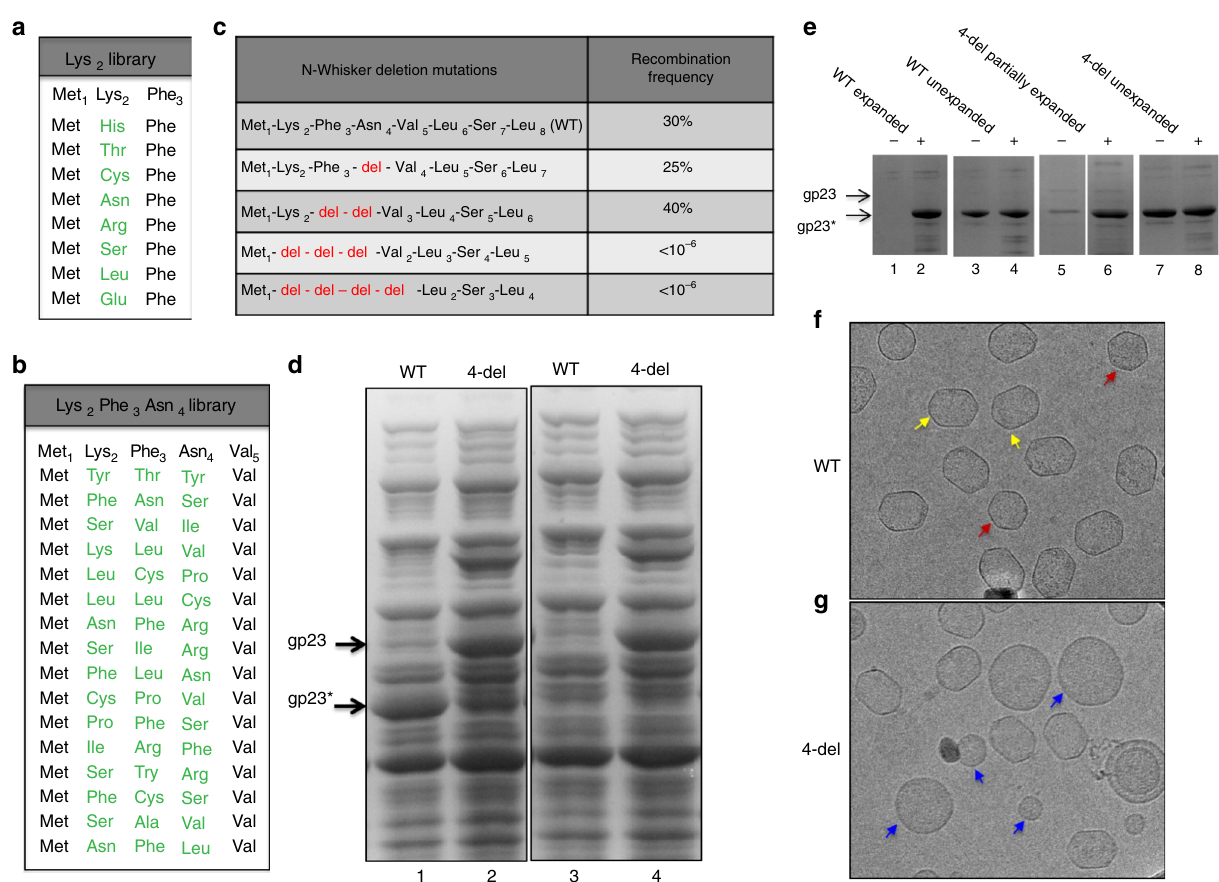
Fig. 5 The N-whisker is essential for capsid assembly. a , b Functional single and three amino acid substitution mutants in N-whisker from CRISPR combinatorial libraries. c Frequencies of recombination that resulted in infectious phage using various deletion mutants in N-whisker. d , e SDS- polyacrylamide gel electrophoresis of lysates of infected E. coli cells (panel d ) and puri fi ed proheads (panel e ). Most of the major capsid protein gp23 was uncleaved in the 4-del portal mutant (lane 2) and remained (unassembled) in the supernatant upon high speed centrifugation (lane 4) whereas it was cleaved to gp23* which occurs only following capsid assembly (lane 1) and very little of it remained in the supernatant (lane 3). e Expanded, partially expanded, and unexpanded proheads puri fi ed by CsCl gradient centrifugation and DEAE ion-exchange chromatography. The samples were concentrated and approximately 2 × 10 10 prohead particles were loaded in each lane. “ + ” and “ − ” represent with and without boiling, respectively, of the puri fi ed prohead samples isolated from the ion-exchange column. The expanded heads are stable and remain intact in SDS without boiling (lane 1; no gp23* enters the gel), whereas the unexpanded capsids dissociate (lane 3). The 4-del mutant showed a partially expanded peak (lanes 5 – 6) but no fully expanded prohead peak as in the WT (lanes 1 – 2) (Supplementary Fig. 5). Note the presence of small amounts of uncleaved gp23 present in the 4-del mutant proheads. f , g Cryo-EM images of the expanded heads puri fi ed from WT and 4-del mutant infections as shown in panel e. Yellow and red arrows identify prolate, icosahedral capsids in side and top views, respectively. Blue arrows identify round capsids of different sizes. See Methods for more